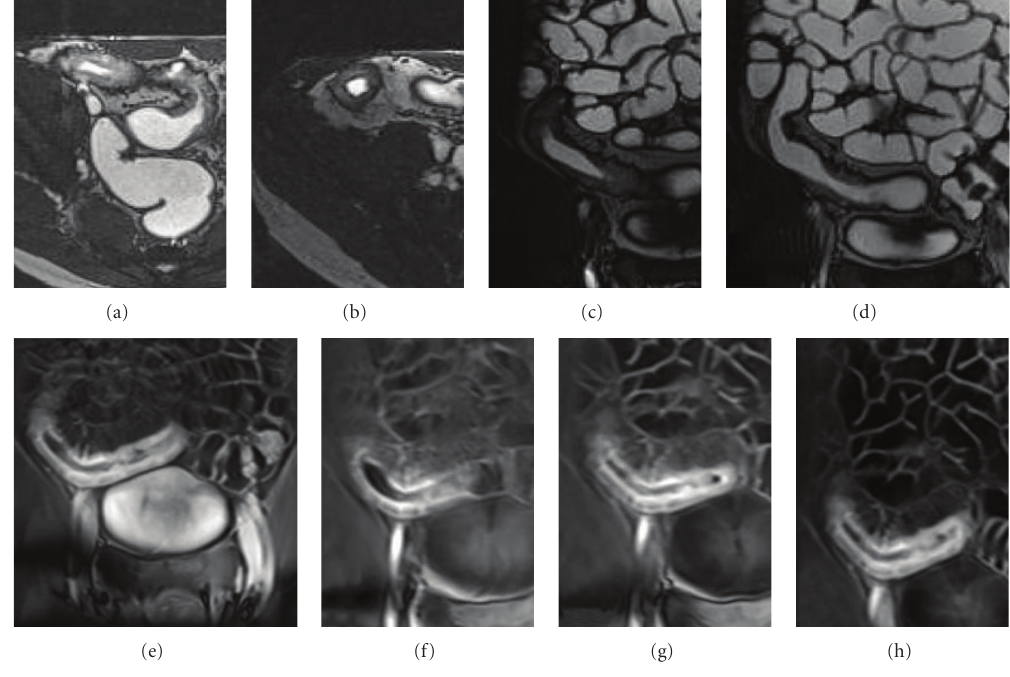
Figure 7: MR-E. Last ileal loop wall thickening (a), (b) axial TRUFI T2. (c), (d) Coronal TRUFI T2. (e) Coronal FLASH 3D. (f), (g), (h) Coronal FLASH 3D postcontrast